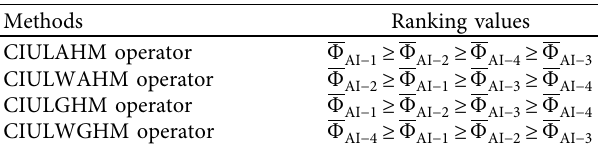
Table 7: Ranking values of the alternatives based on score values by different